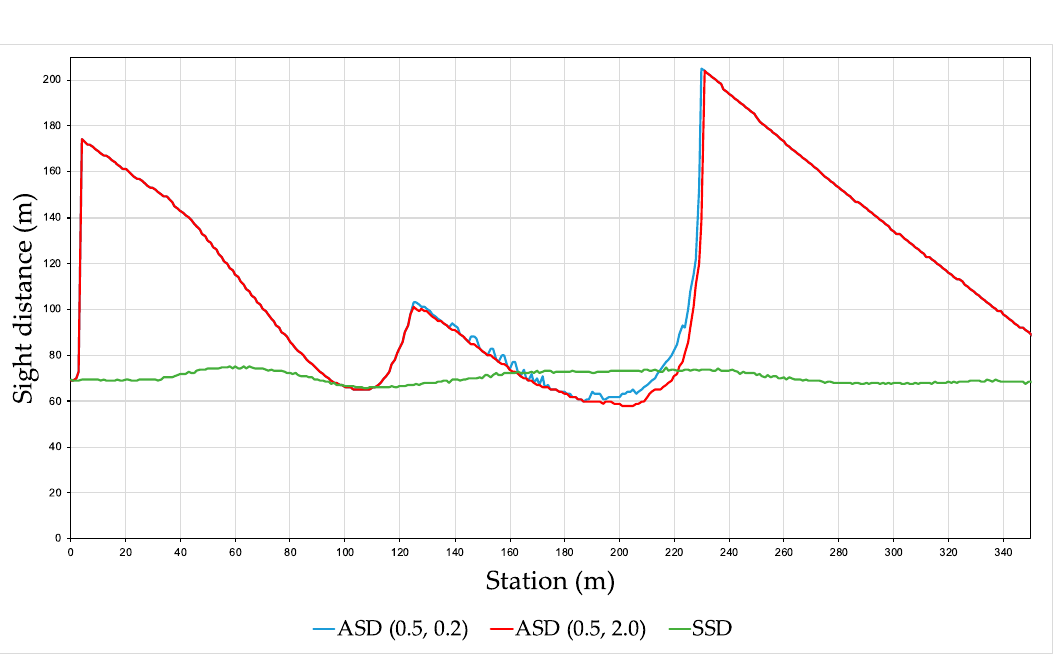
Figure 7. Visibility results with distinct resolutions for aboveground elements.